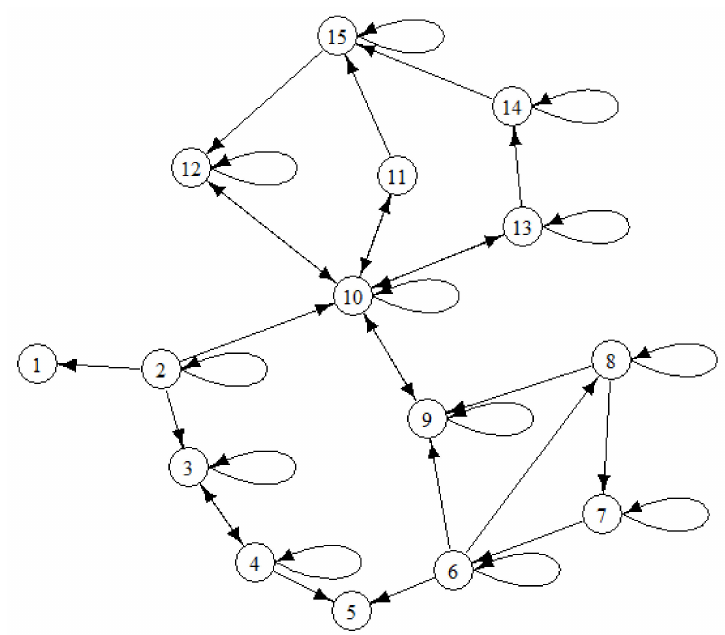
Figure 1. Graph for model example.